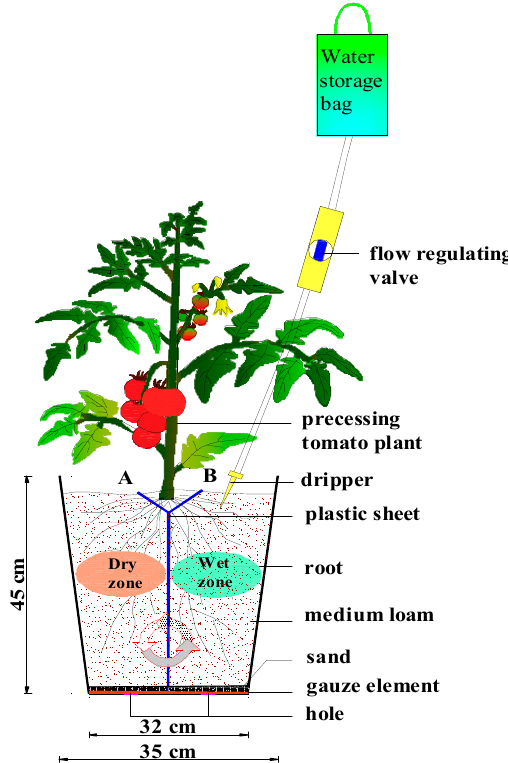
Figure 3. Diagram of roots in the pots.